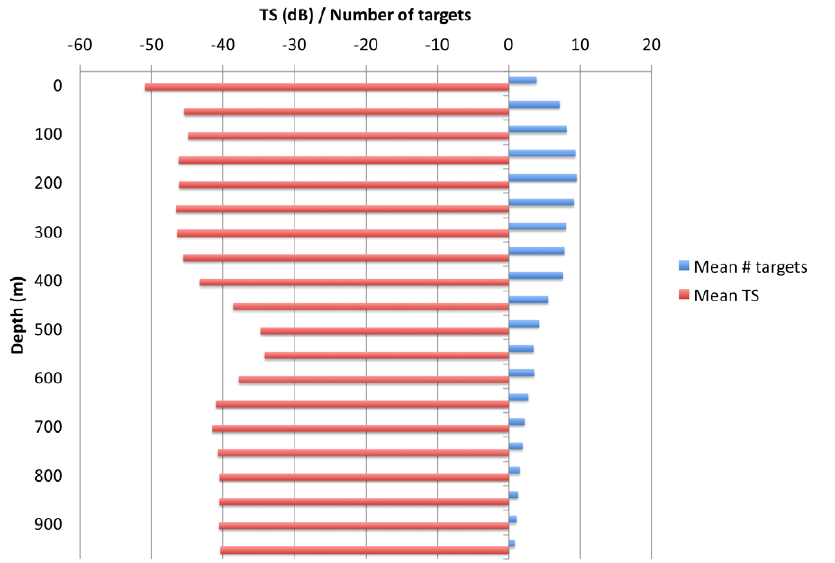
Figure 3. The mean number of targets, target size, and mean scattering volume with depth for the entire study area. There was a peak in 9 targets/2500 m 2 at 200–250 m, a peak in target size of 2 35 dB at 550–600 m, and a peak in mean scattering volume at 500 m.